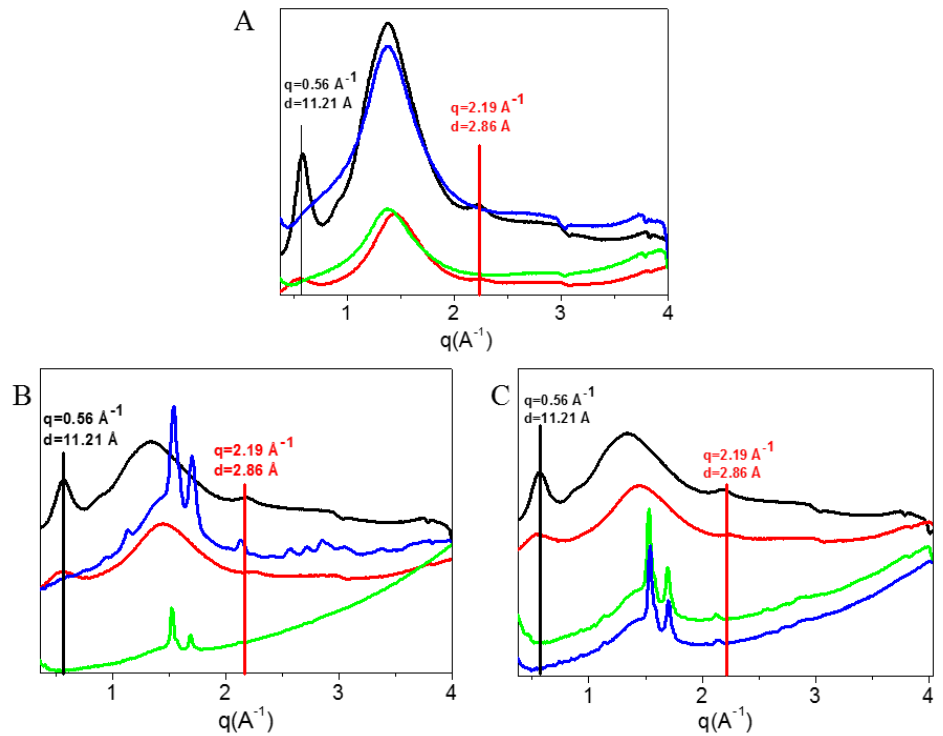
Figure 8. WAXS 1D profiles obtained from radial integration of 2D diffraction patterns. ( A ) WAXS spectra of native collagen (black), collagen in 90% (v/v) acetic acid aqueous solution (red) and collagen electrospun nanofibers with different weights 15 mg (green) and 55 mg (blue) (protein concentration in all samples: 20% w/w). ( B ) WAXS spectra of native collagen (black profile), collagen in 90% (v/v) acetic acid aqueous solution (red profile) and collagen/PCL mixtures with 1:2 weight ratio (green profile) and 1:1 weight ratio (blue profile) weight ratio respectively, before the electrospinning. ( C ) WAXS spectra of native collagen (black profile), collagen in 90% (v/v) acetic acid aqueous solution (red profile) and collagen/PCL electrospun nanofibers with 1:2 weight ratio (green profile) and 1:1 weight ratio (blue profile), after the electrospinning treatment.